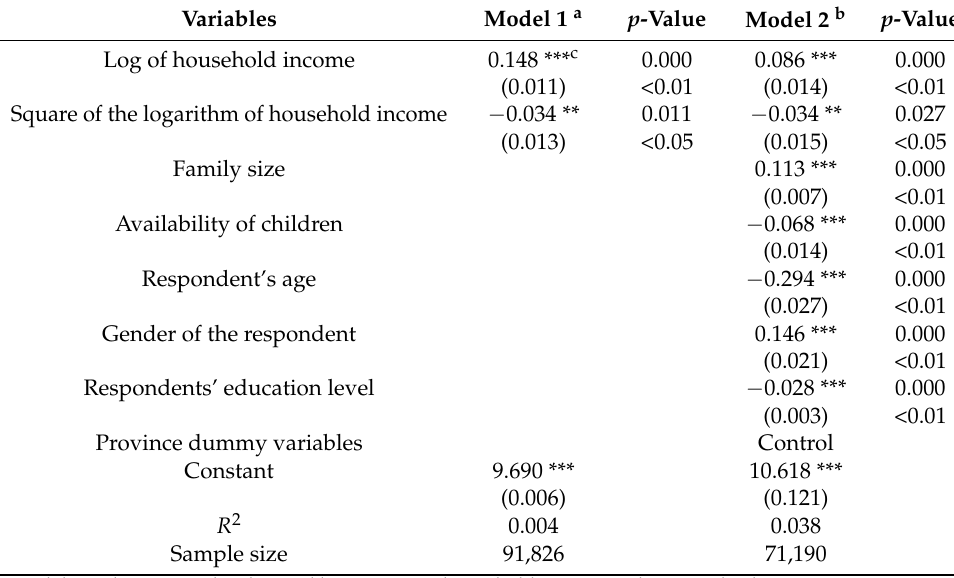
Table 2. Effect of household income on consumption of sugary